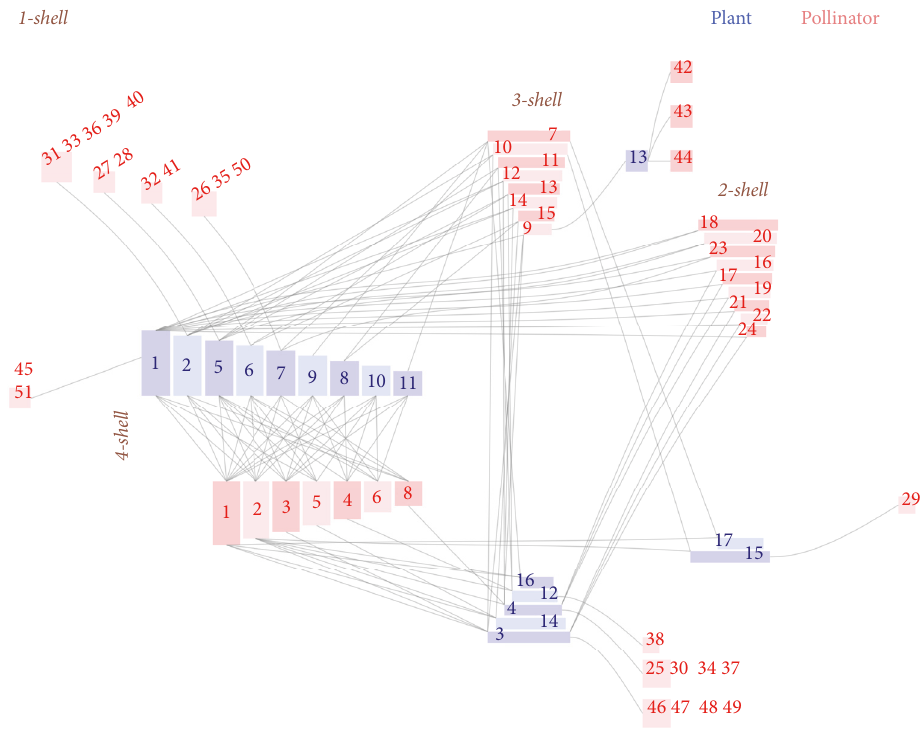
Figure 4: Ziggurat plot of the same plant-pollinator community in Tenerife, Canary Islands (Spain), that appears in Figure 1.